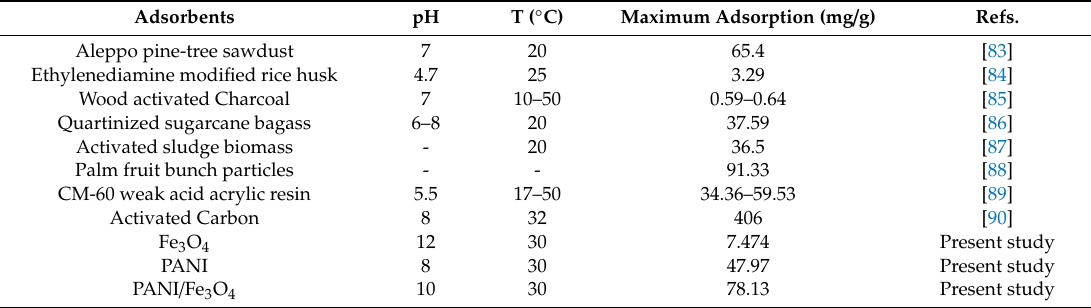
Table 3. Comparative adsorption of BB3 on Fe 3 O 4 , PANI, and PANI / Fe 3 O 4 with other